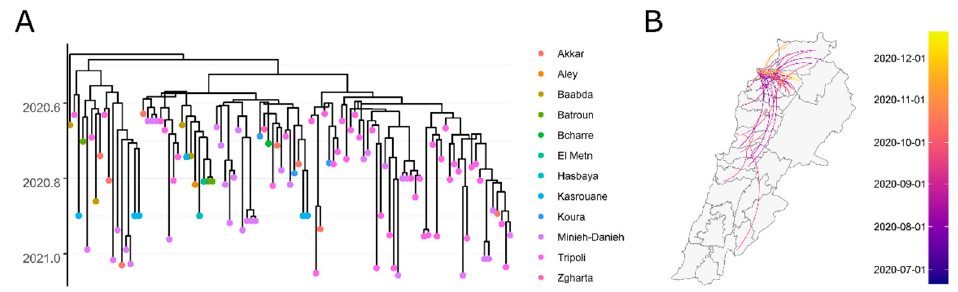
Figure 3. Phylodynamics of the B.1.398 lineage in Lebanon. In ( A ), we see the time tree of B.1.398, indicating divergence times between genomic sequences, with colors representing the districts in Lebanon. The Tripoli district acted as a dispersal hub in the country, as displayed in ( B ). Colors in ( B ) indicate the time at which dispersal started.